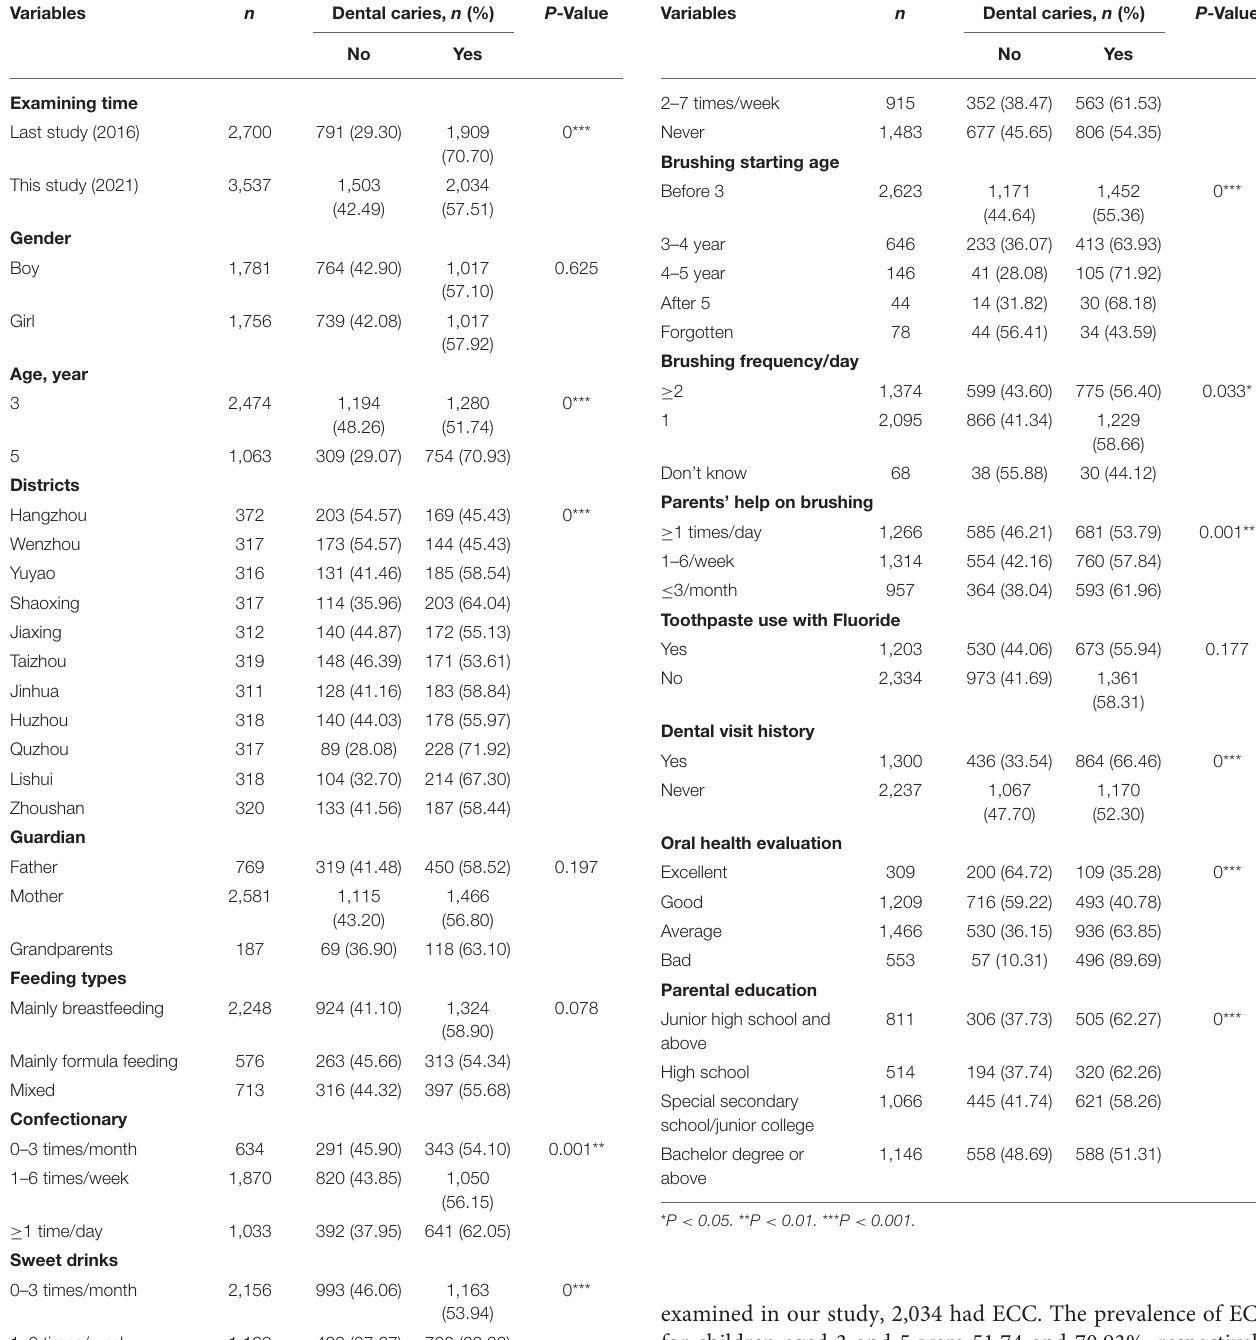
TABLE 1 | Distributions of related variables for